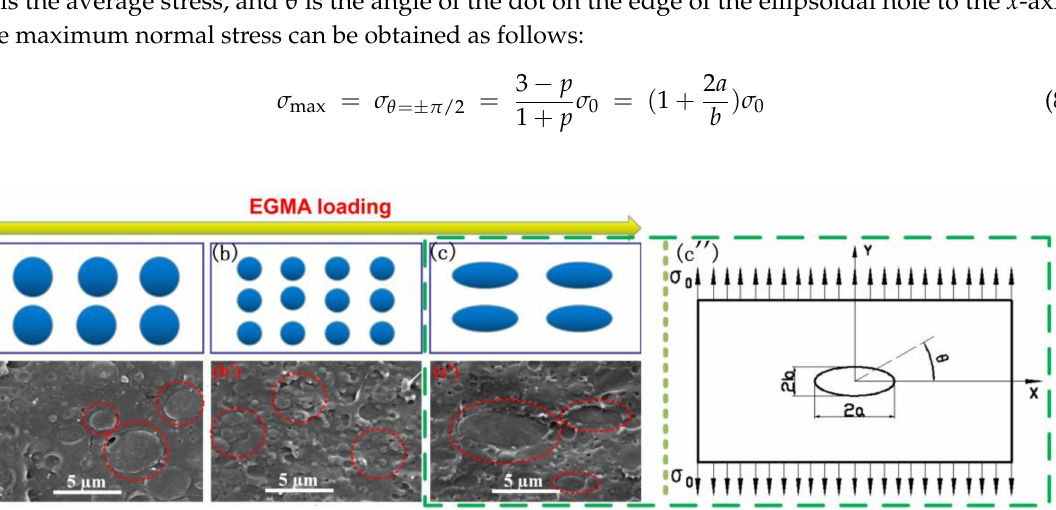
Figure 10. Evolution of PBS particle shape in phase morphology with the inclusion of EGMA:( a,a’ ) PLA/PBS 70/30; ( b,b’ ) PLA/PBS/EGMA 70/30/10; ( c,c’ ) PLA/PBS/EGMA 70/30/10; ( a – c ) schematic diagram; ( a’ – c’ ) SEM images of cryofracture surfaces; ( c” ) analysis